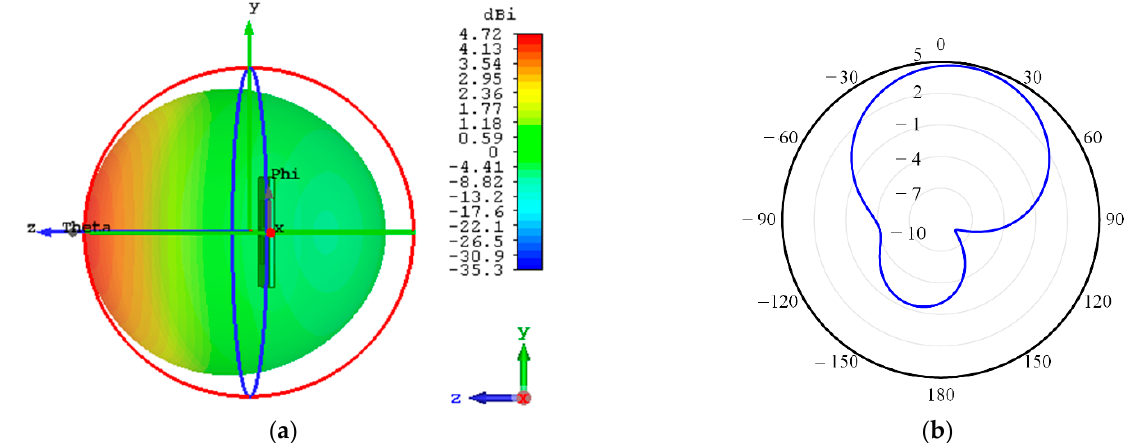
Figure 7. The simulated directivity of the proposed antenna with FR-4 substrate at 2.4 GHz ( a ) 3D and ( b ) 2D.